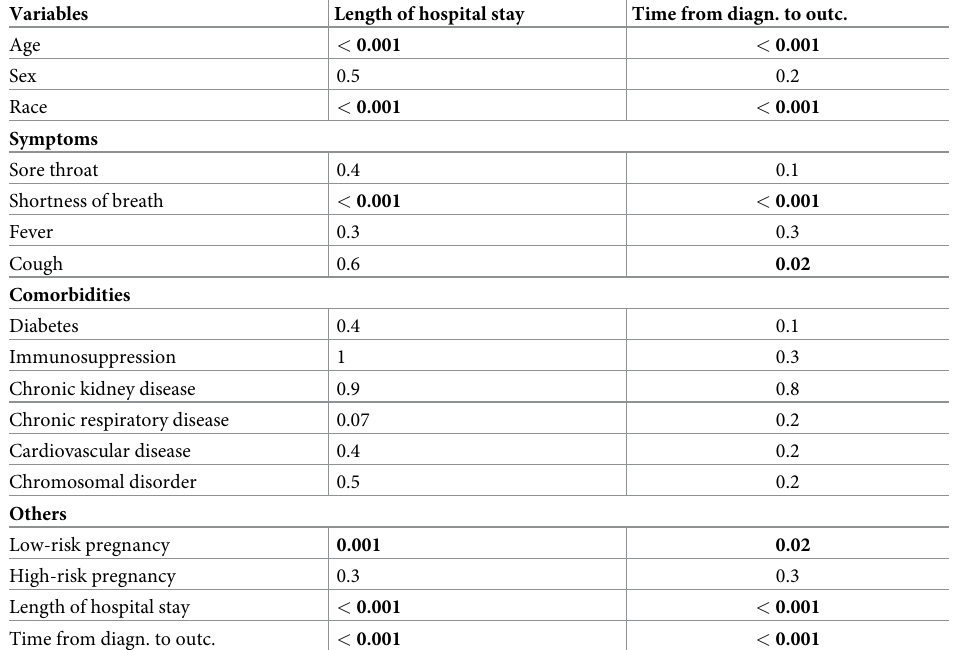
Table 3. A matrix of p-values between hospitalized patients’ demographics, symptoms, medical history, length of hospital stay and time from diagnosis to definitive outcome. Variables Length of hospital stay Time from diagn. to outc.